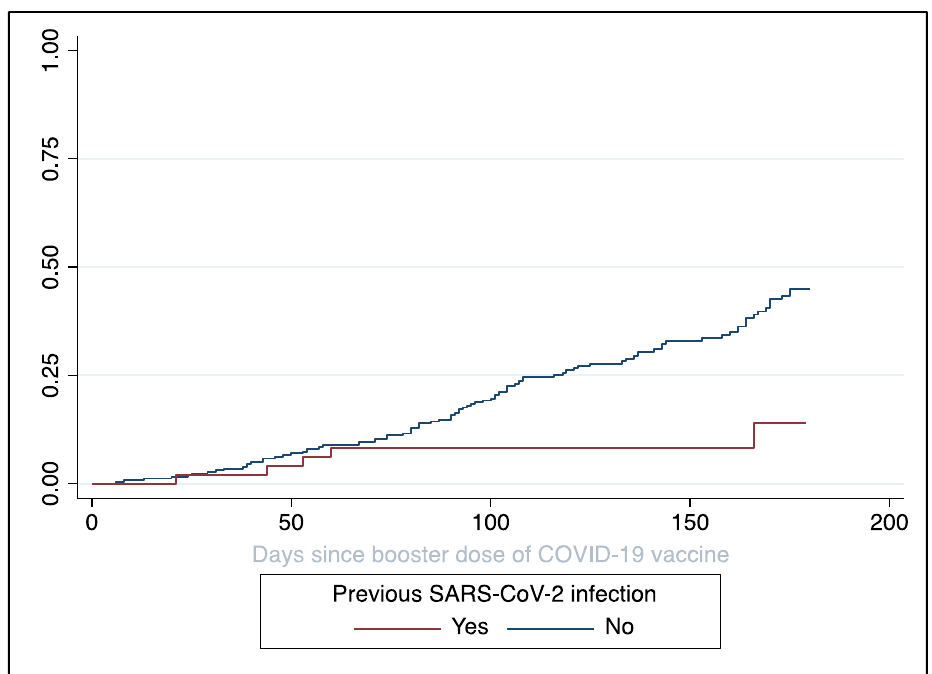
Figure 2. Kaplan–Meier curve for follow-up (reverse-Kaplan–Meier) according to the previous SARS-CoV-2 infection. The y -axis shows cumulative incidence of breakthrough infections. Table 2. Cox multivariate regression model indicating associations between the occurrence of break- through infection with SARS-CoV-2 and characteristics evaluated (N =